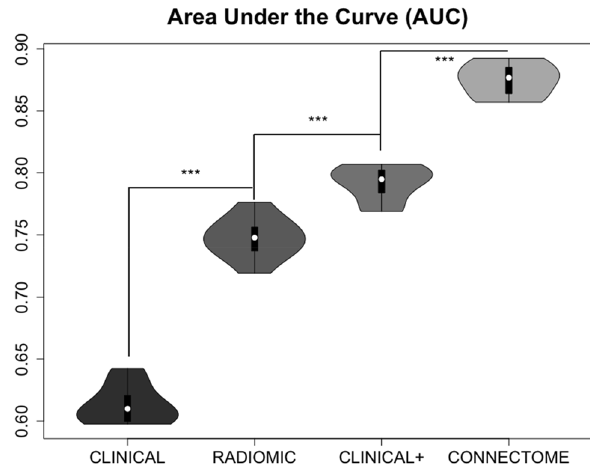
Figure 2. Violin plots of AUC values across 10-folds cross-validation. The connectome model (AUC 0.88 ± 0.01) demonstrated superior performance compared to the clinical (AUC 0.61 ± 0.02), clinical + (AUC 0.79 ± 0.01) and radiomic models (AUC 0.75 ± 0.02) in predicting overall survival. The clinical + and radiomics models outperformed the clinical model and the clinical + model outperformed the radiomics model. *** P < 0.001,